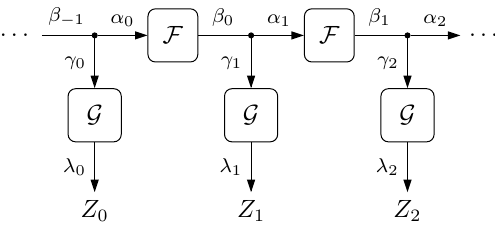
Figure 2: Linear masks α i , β i , γ i , λ i for 3 consecutive keystream blocks Z i of AEGIS . Additionally, we need masks for the inputs of the SubBytes , ShiftRows , and MixColumns layers, denoted as σ i , ρ i , and µ i , respectively. The output mask of MixColumns must equal the corresponding round function output mask β i due to the following Xor